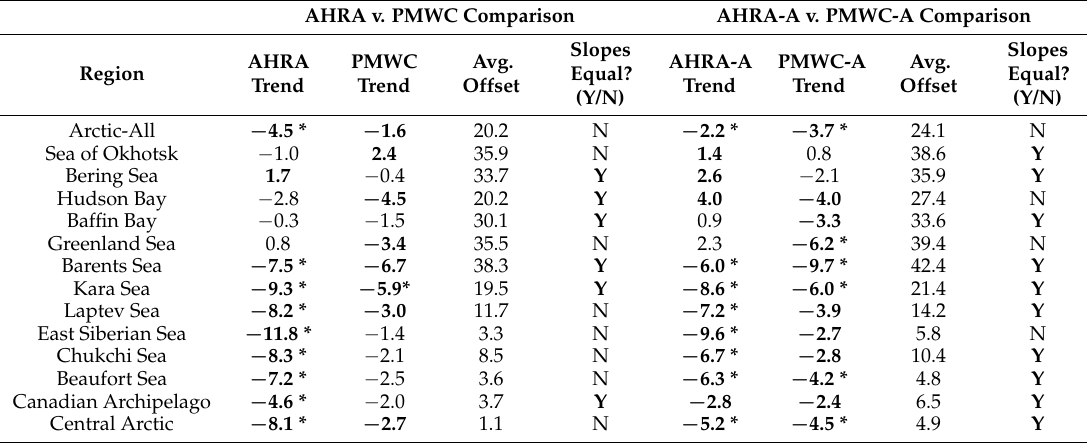
Table 3. Trends a (days · decade − 1 ), average offsets b (days), and slope comparison c results for